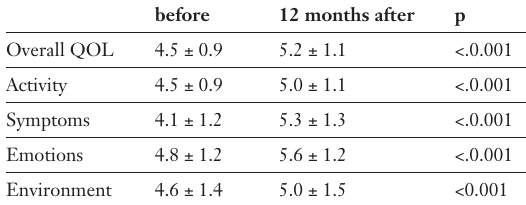
Quality of life (QOL) before and 12 months after thera- peutic intervention.